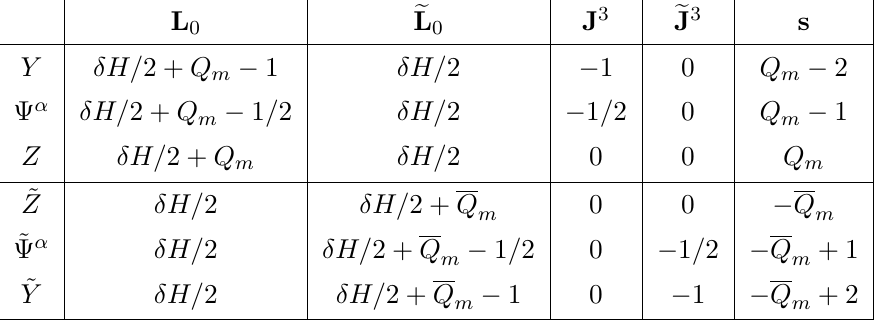
Table 2 . Charges of the massive particles and their mirror theory bound states under the Cartan